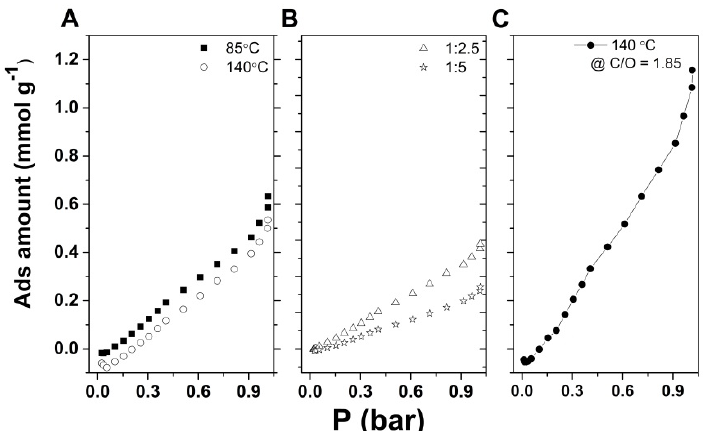
Figure 7. CO 2 adsorption isotherm for EDA-functionalized GO aerogels obtained from a 2 mg·mL − 1 GO dispersion where GO/EDA = 1:2.5 at 85 and 140 °C ( A ), aerogels obtained from a 6 mg·mL − 1 GO dispersion where GO/EDA = 1:2 and 1:5 ( B ), and aerogel obtained at 140 °C from a 2 mg·mL − 1 dispersion of GO where C/O = 1.85 and GO/EDA = 1:2.5 ( C ).